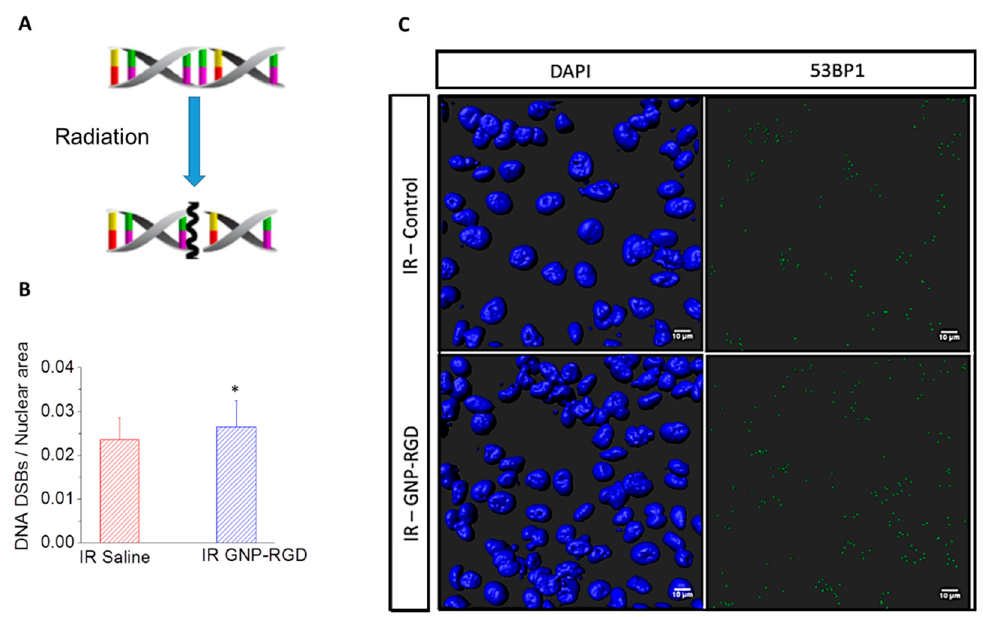
Figure 5. ( A ) Illustration of DNA double strand break from radiation treatment; ( B ) DNA DSBs per nuclear area for MDA-MB-231 cells treated with saline (control) and GNP-RGD prior to 2 Gy, 6 MV radiation; * represents statistically significant difference (unpaired t -test, p < 0.05) ( C ) Qualitative representation of ( B ). The nucleus is stained with DAPI (shown in blue) and the markers for DNA DSBs, 53BP1, are shown in green. Scale bar = 10 µm .